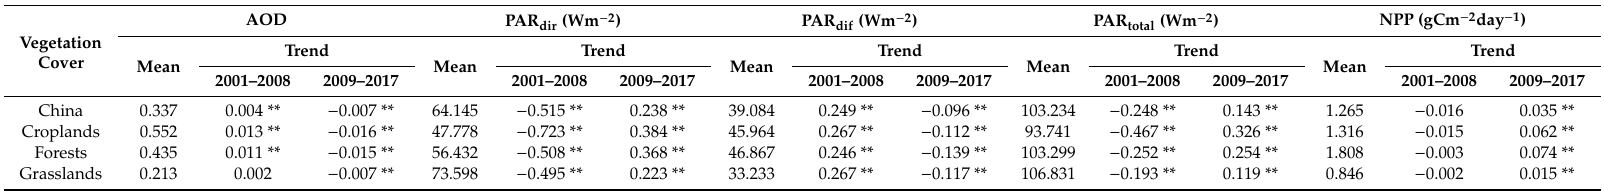
Table 1. Multi-year mean value and trends of yearly mean AOD, PAR and NPP for croplands, forests and grasslands during 2001–2018 and 2009–2017. Vegetation Cover